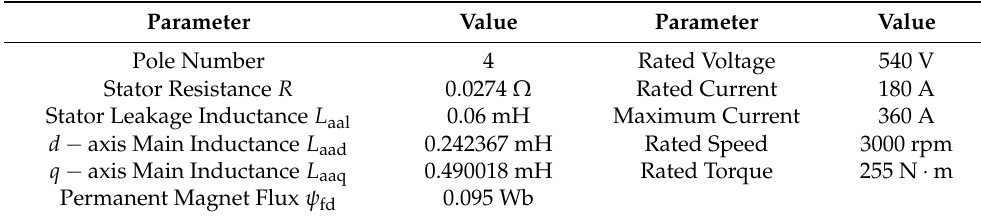
Table 1. Parameters of the DTPMSM in the